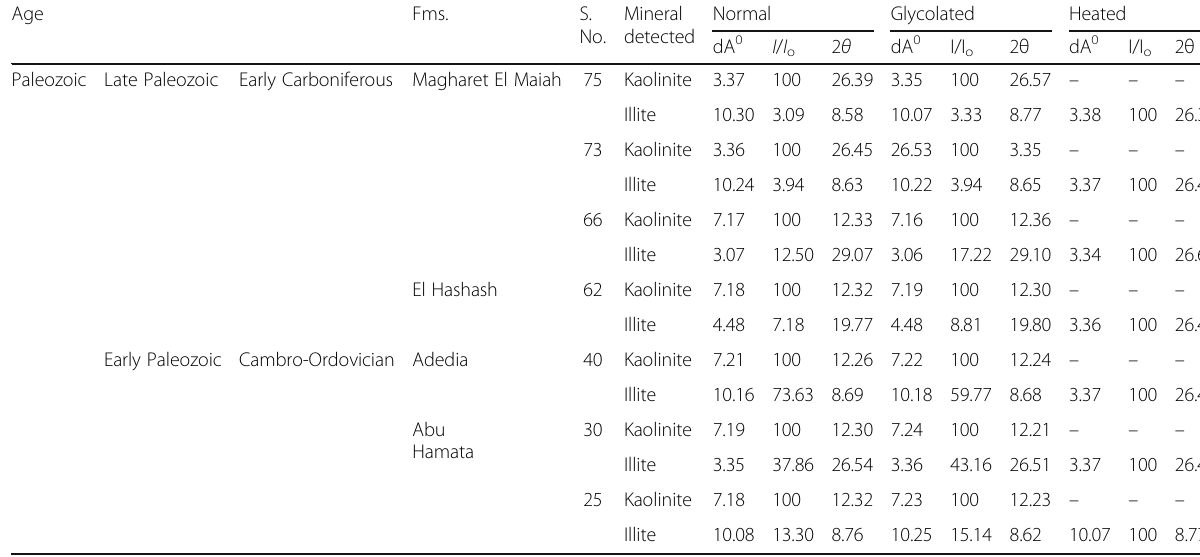
Table 1 X-ray diffraction data of different Paleozoic studied rock units Age Fms.